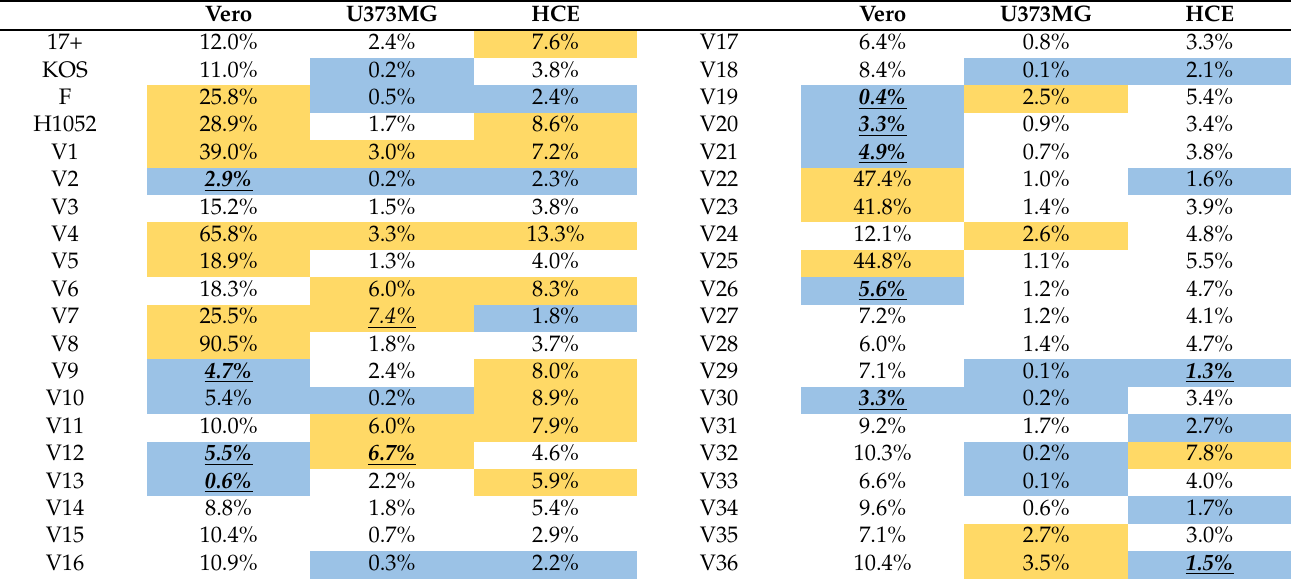
Table 3. Proportions of extracellular to cell-associated virus. The mean proportions of extracellular to cell-associated virus were determined based on the data of Figure 2. Each column lists them for a cell line, and the highest 10 ratios within a cell line are colored yellow, whereas the lowest 10 are colored blue. Those highlighted in yellow represent viral strains with the highest extracellular shedding capability within a cell line, whereas those colored blue represent the most cell-associated viral strains. Each proportion is compared to that derived from 17+ from the same cell line. Any significant difference to 17+ is shown with a number that is in bold, in italics, and